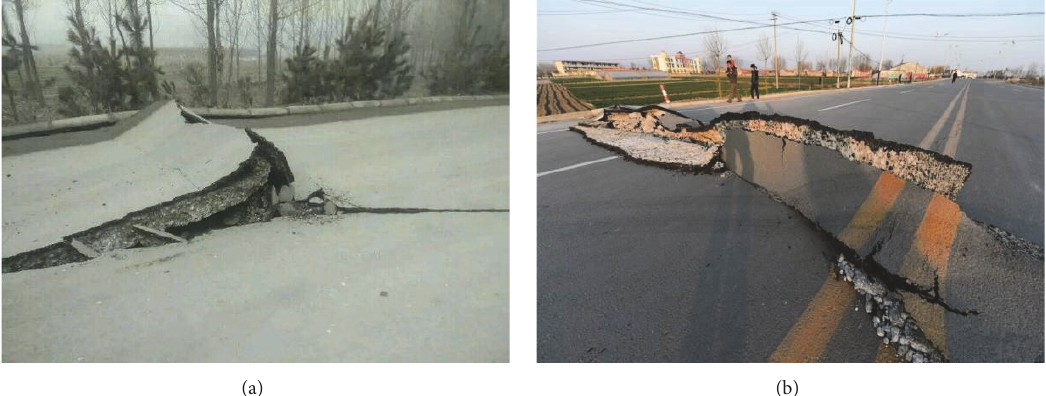
Figure 1: The damage of roads caused by the collapse of underground goafs in Shengda iron mine, where the vibration intensity was equal to an earthquake with the magnitude 3.1.